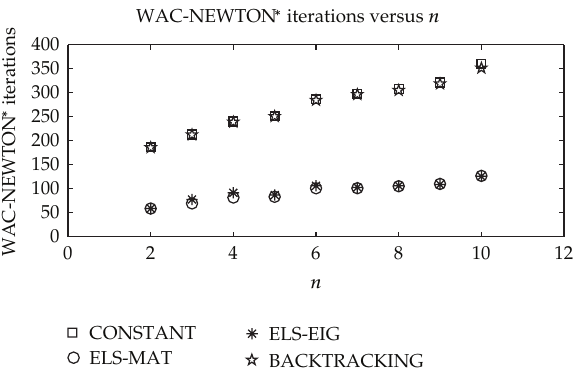
Figure 8: SDP-CUT iterations against the number of variables n .